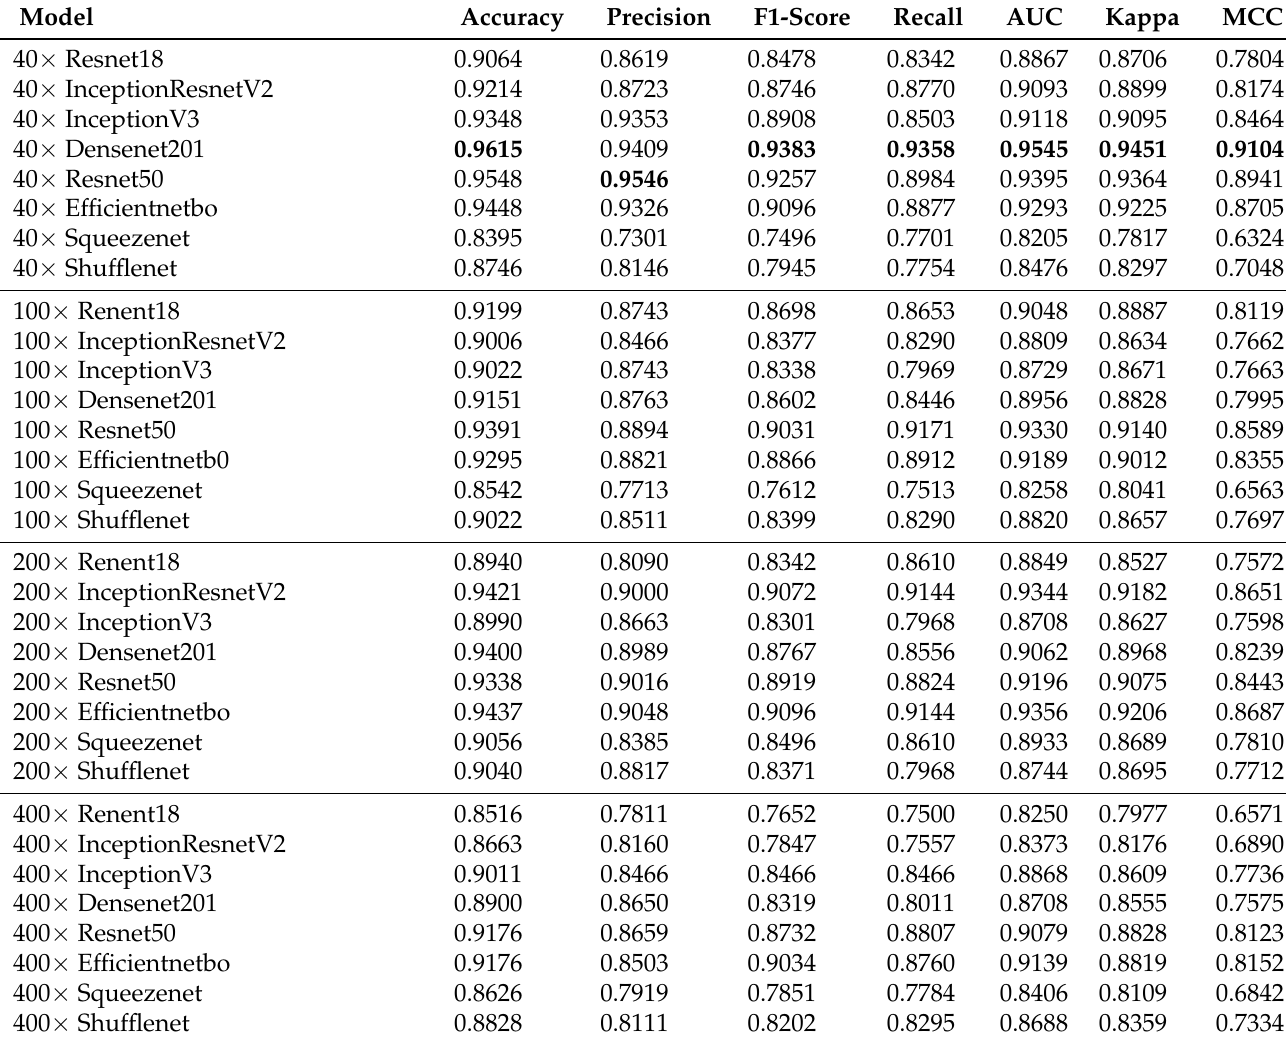
Table 8. Binary (benign vs. malignant) classifier performance: comprehensive table of metrics for deep features extracted from different individual magnifications of histopathological images using fine-tuned CNN models that are classified using SVM (no pooling of features to create a bag